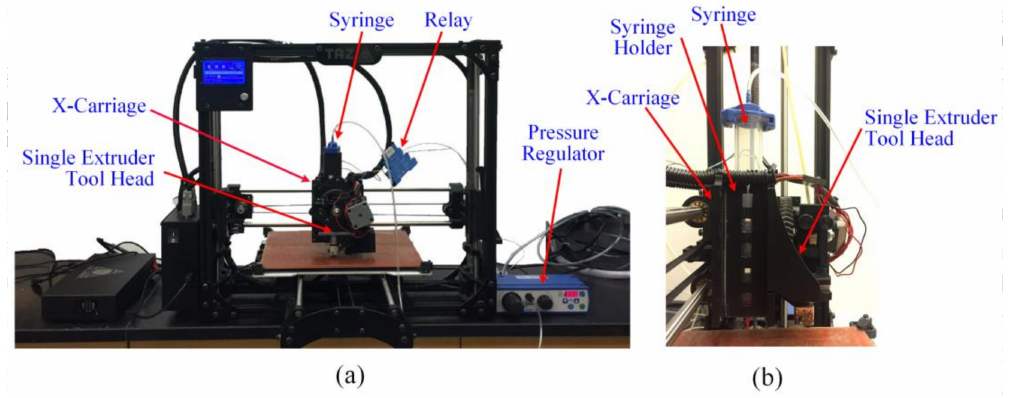
Figure 1. Experimental setup ( a ) overview and ( b ) close-up sideview of the syringe holder assembly with the single extruder tool head.